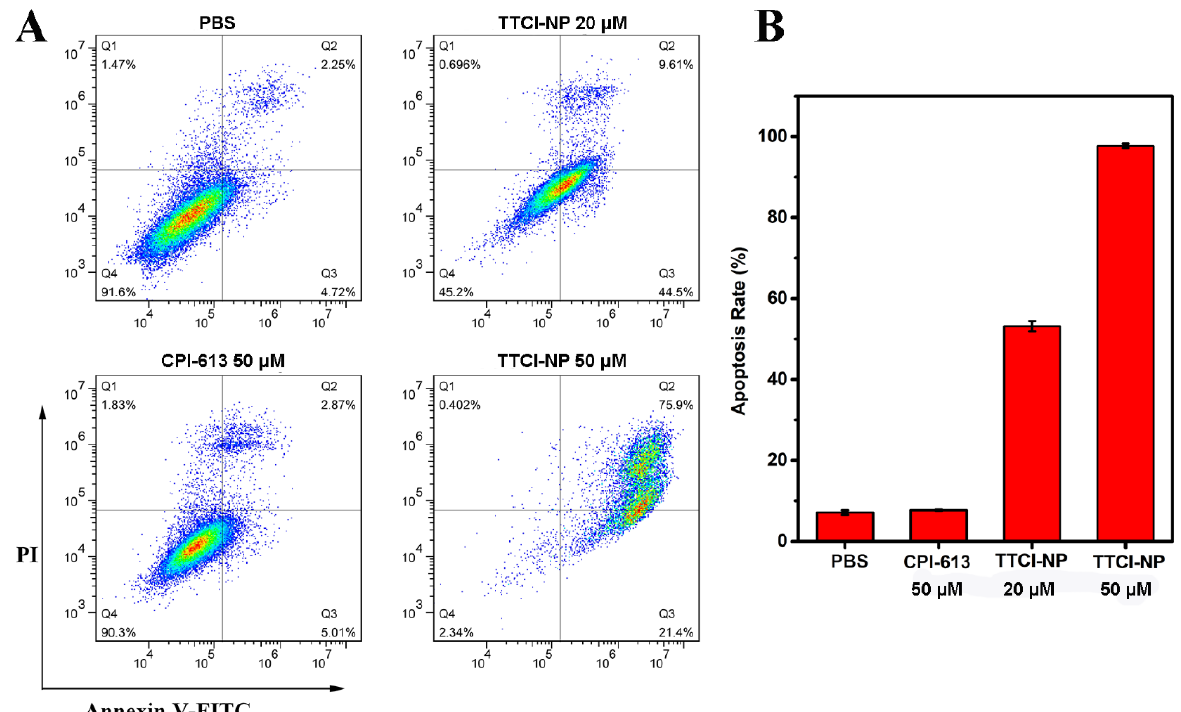
Figure 5. The effects on apoptosis of free CPI-613 and CPI-613-loaded TTCI NPs at various concentrations. BxPC3 cells were treated with 50 µ M CPI-613, 20 µ M TTCI NPs and 50 µ M TTCI NPs for 48 h and apoptosis was determined by flow cytometry with Annexin V-FITC/PI staining (A) . The apoptosis rate (B) following treatment with various therapeutics.